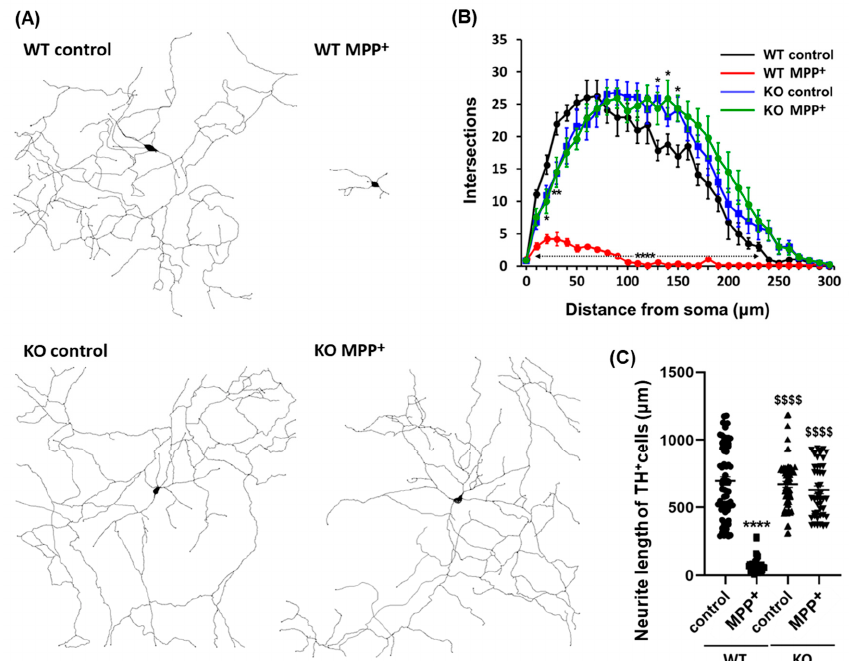
Figure 3. Representative dendritic morphology of TH + dopaminergic neurons derived from wild type or FABP3 − / − mice. ( A ) Representative traced dendritic patterns of wild type (WT) or FABP3 − / − (KO) dopaminergic neurons either treated or not treated with 10 µ M MPP + for 48 h. ( B ) Sholl analysis of WT or FABP3 KO dopaminergic neurons either treated or not treated with MPP + . **** p < 0.0001, ** p < 0.01, * p < 0.05 versus WT control, n > 20. ( C ) Average neurite length of WT or FABP3 − / − dopaminergic neurons. **** p < 0.0001 versus WT control; $$$$ p < 0.0001 versus WT MPP + , n > 20.